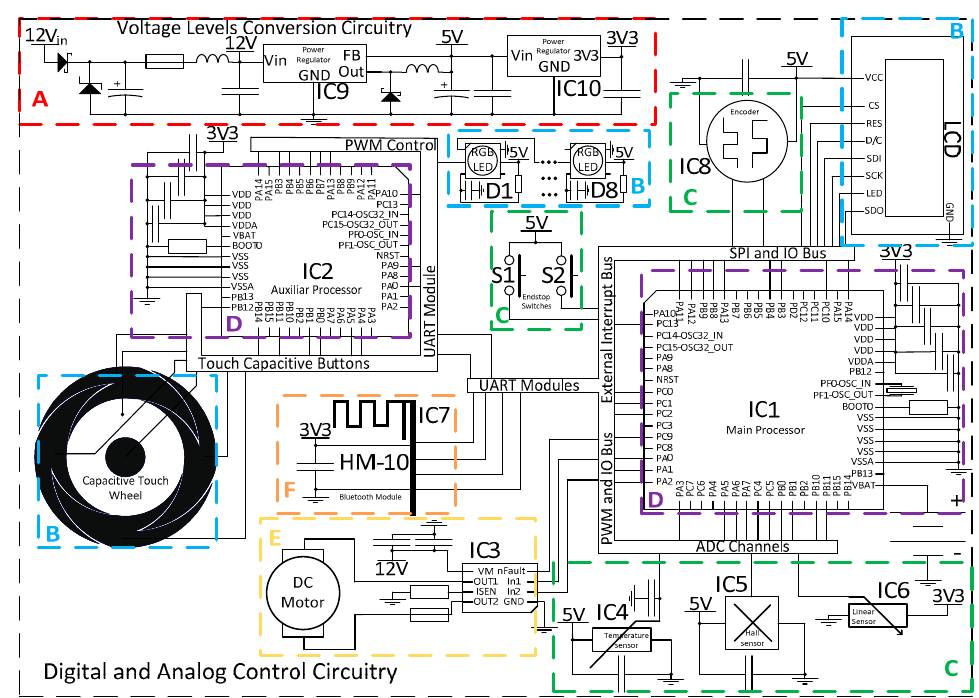
Figure 4. Main circuits used for the power conversion ( A ), user interface ( B ), sensors ( C ), system control ( D ), actuators ( E ) and wireless communications ( F ).